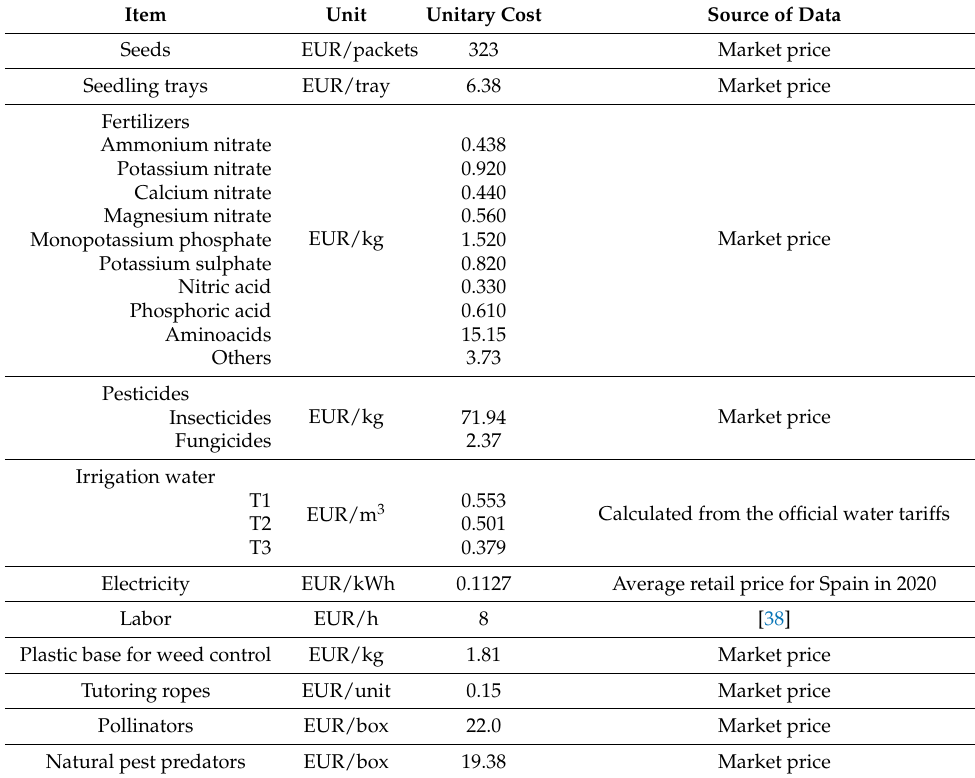
Table 2. Unitary costs of variable productive